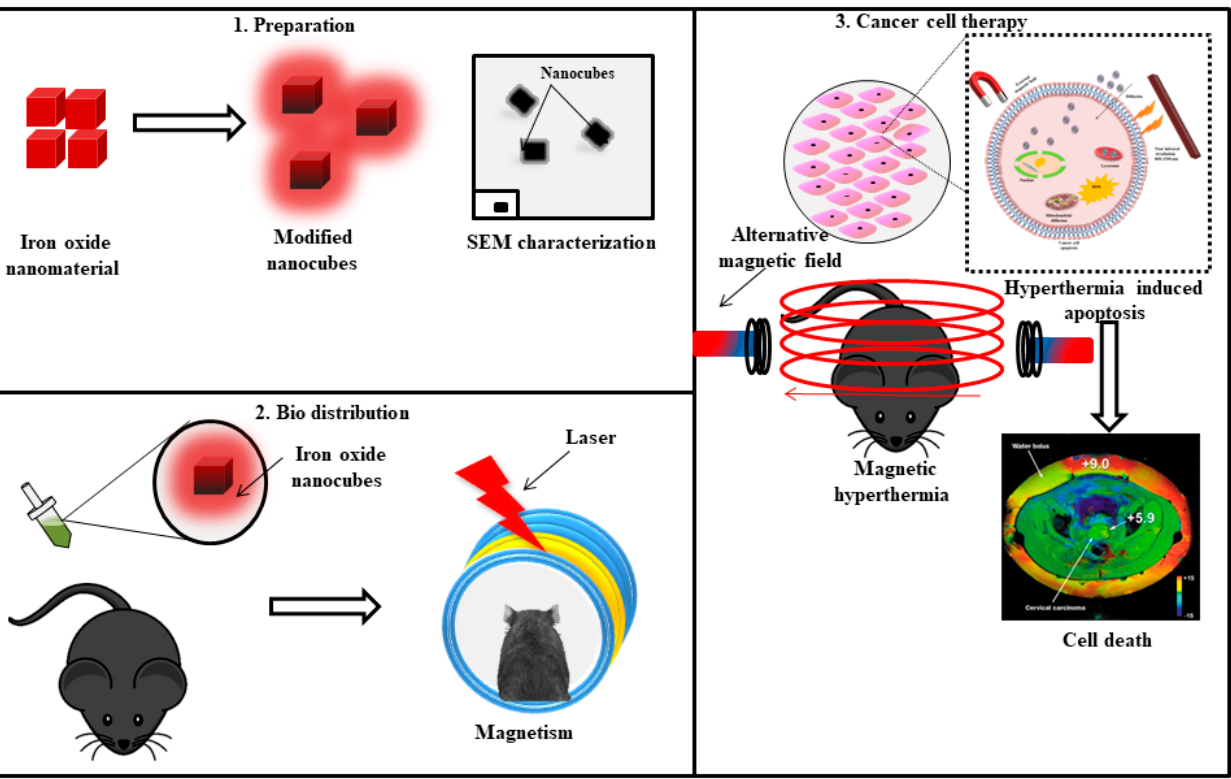
Figure 4. Iron oxide nanocubes for targeting cancer cells and ROS generation due to hyperthermia in the presence of external magnetic field and near infrared region (NIR).